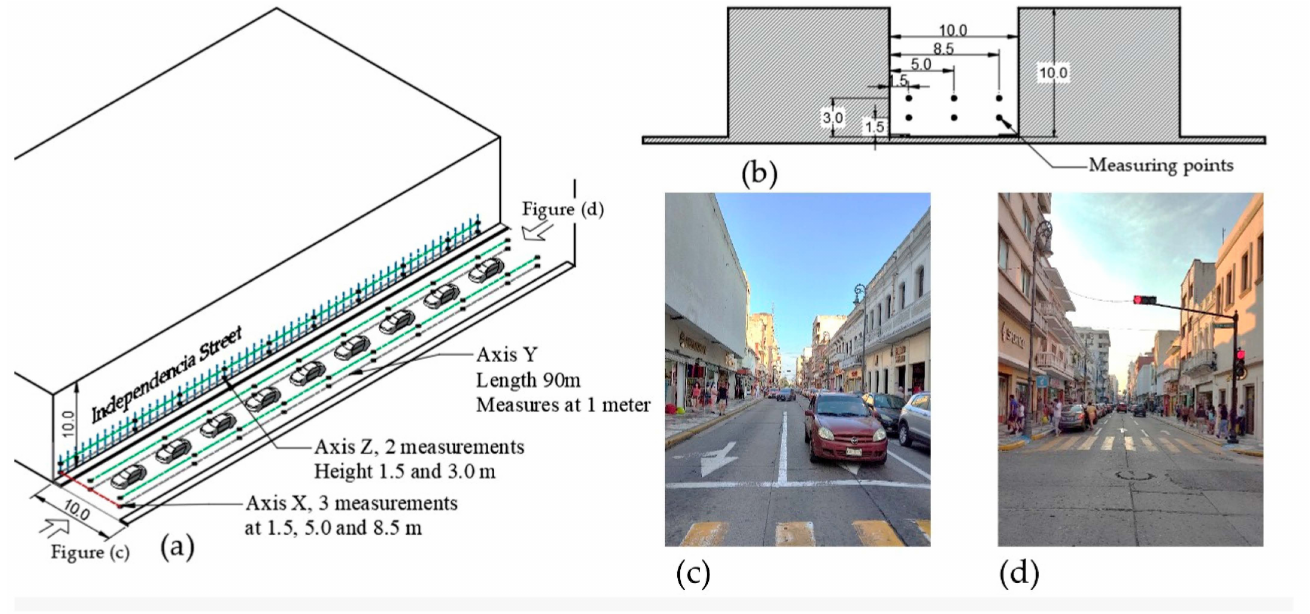
Figure 2. ( a ) Isometric of the urban canyon locating the axes X, Y, and Z. ( b ) Section with dimensions of the “in situ” measurements. ( c ) View from south to north of the street. ( d ) North view of the street.